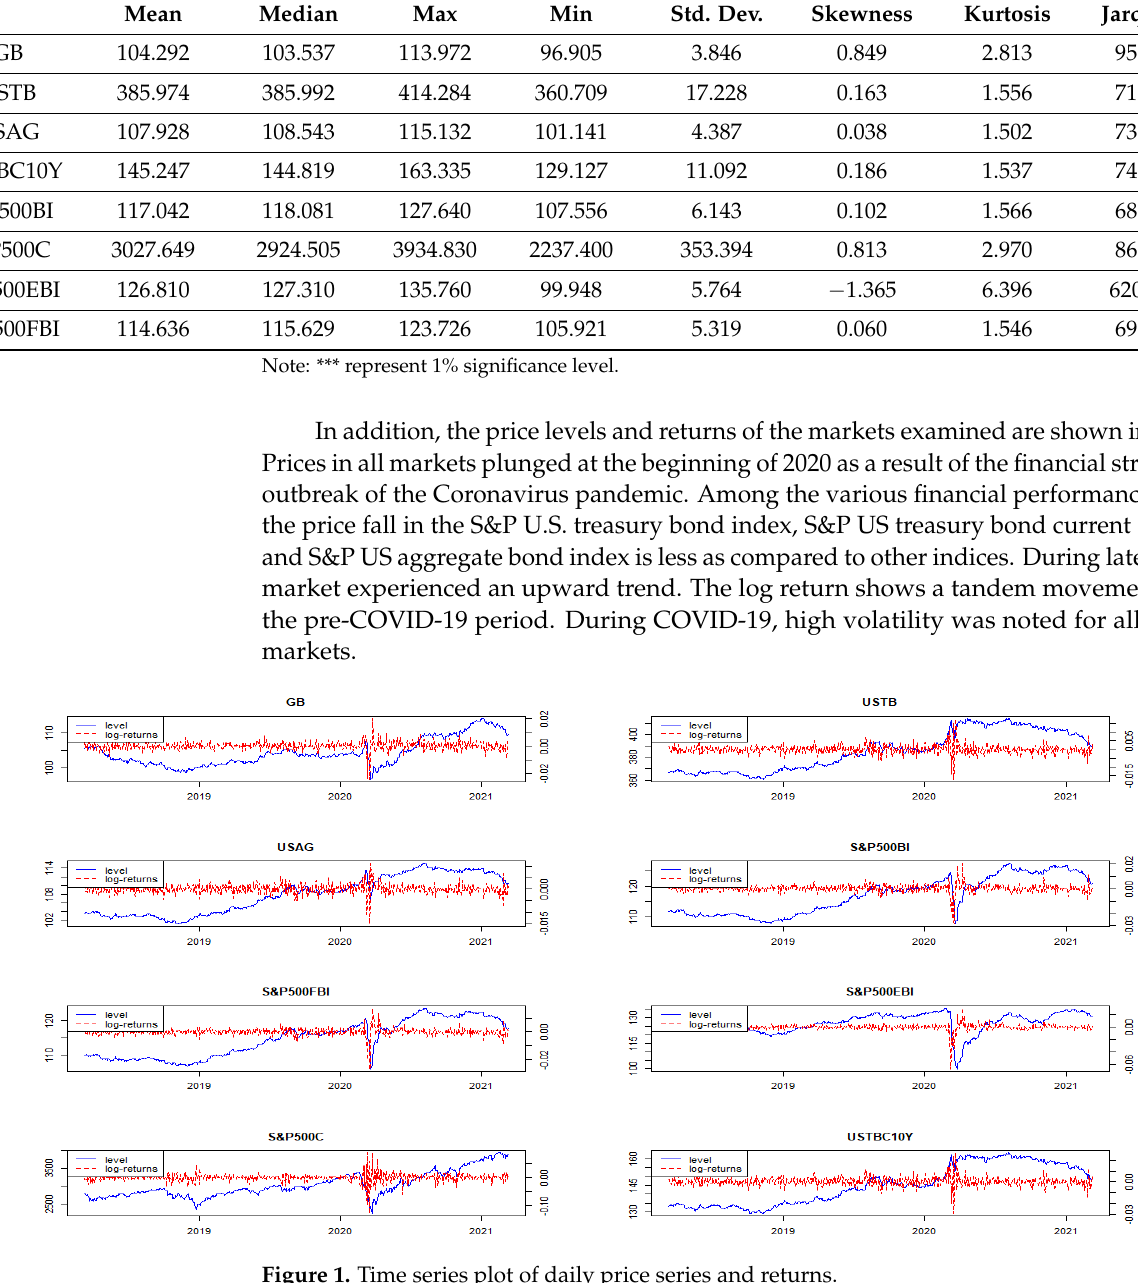
Figure 1. Time series plot of daily price series and returns. Figure 2 denotes the pairwise correlation coefficient with results showing that green bonds are more strongly correlated with the S&P 500 composite index, while it is weakly correlated with the S&P 500 US treasury bond index. The degree of correlation is highest between the S&P 500 US treasury bond index and the S&P US treasury bond current 10Y index. The S&P 500 composite index and S&P 500 energy index are weakly connected with each other.